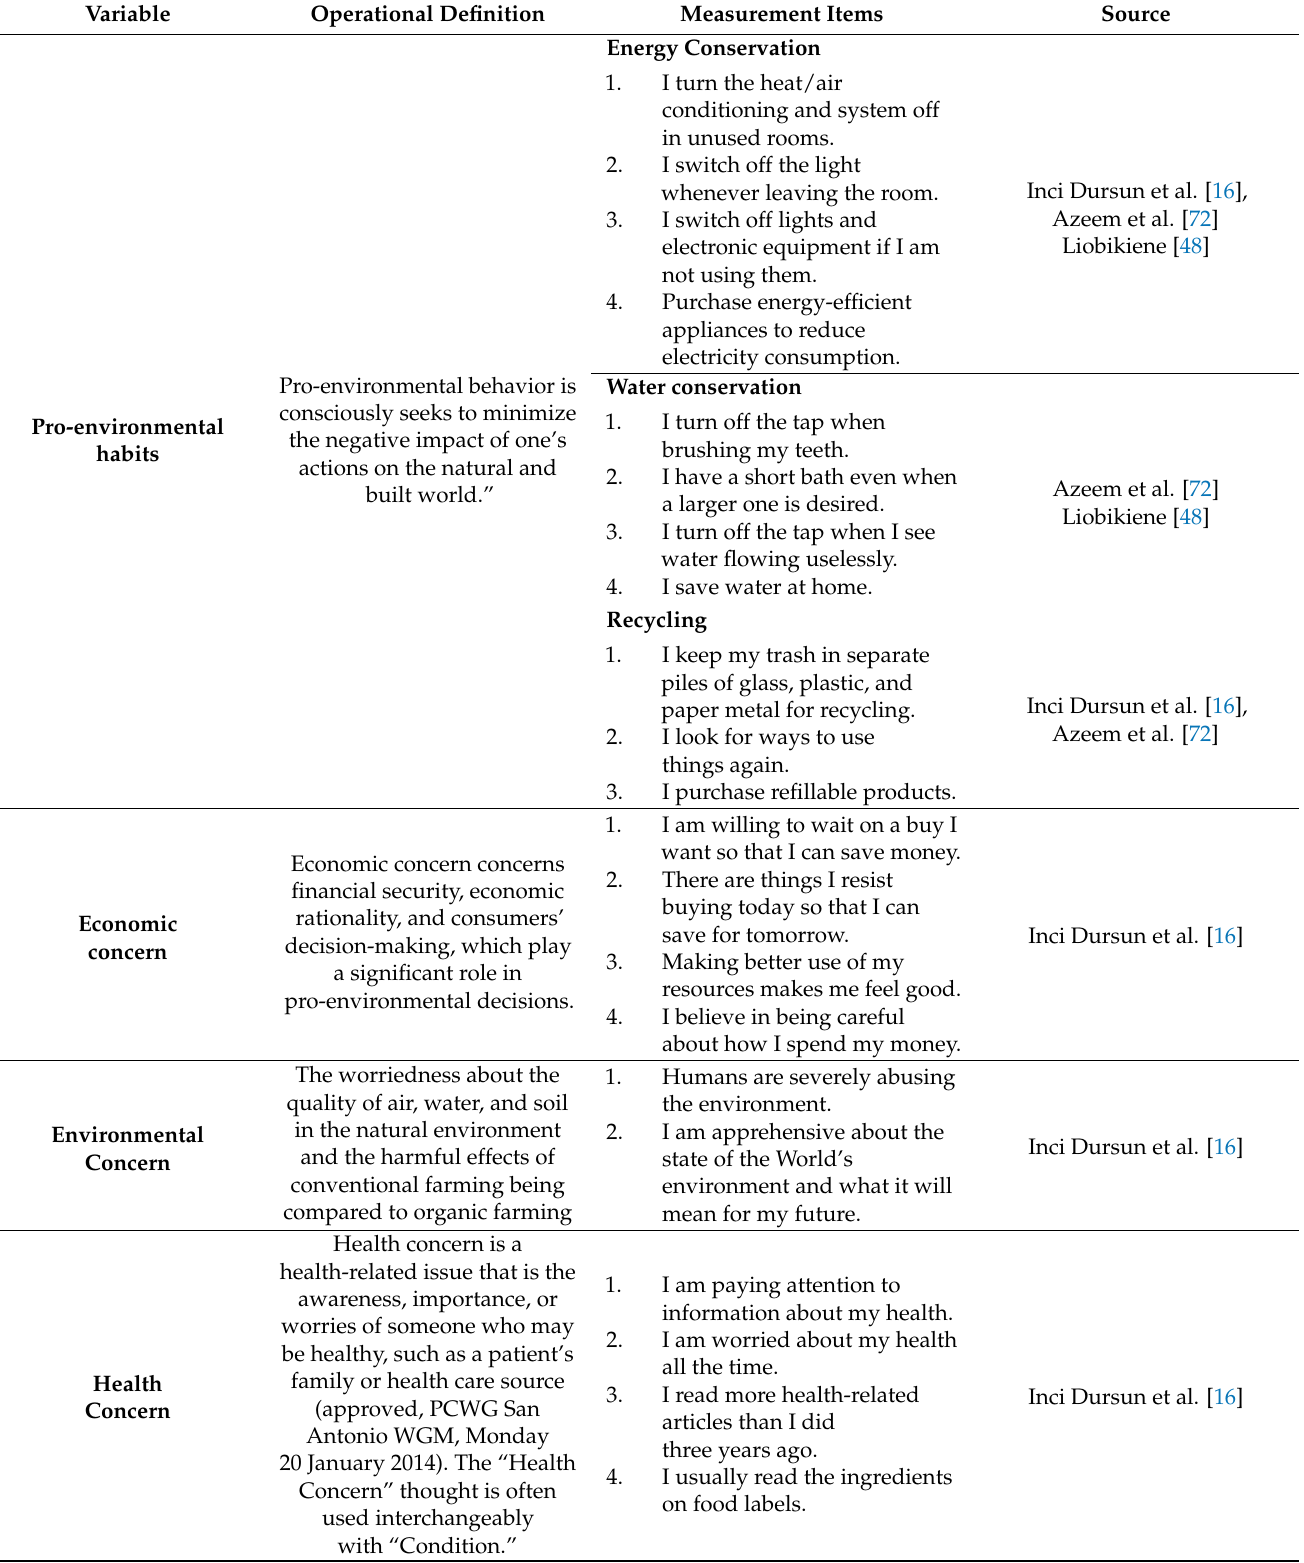
Table 1. Measurements of the